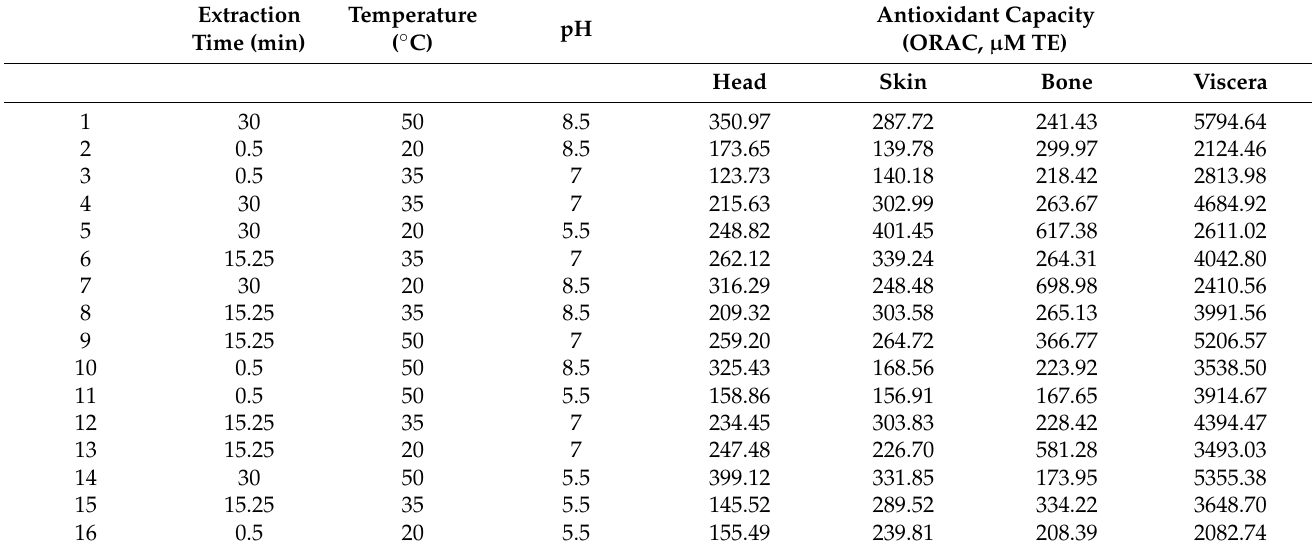
Table 7. Antioxidant capacity values obtained by oxygen radical absorbance capacity (ORAC) assay ( µ M TE) from fish side streams extracts at different UAE (ultrasound-assisted extraction) times (min), temperatures ( ◦ C), and